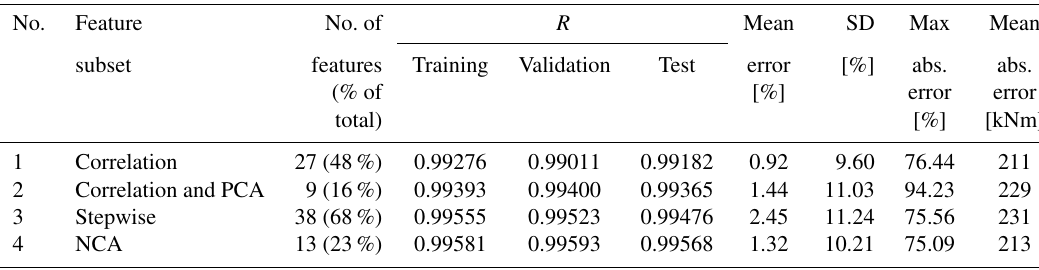
Table 6. Results from using the trained model to predict the remaining 50% of the data. No. Feature No. of Mean SD Max Mean subset features error abs.